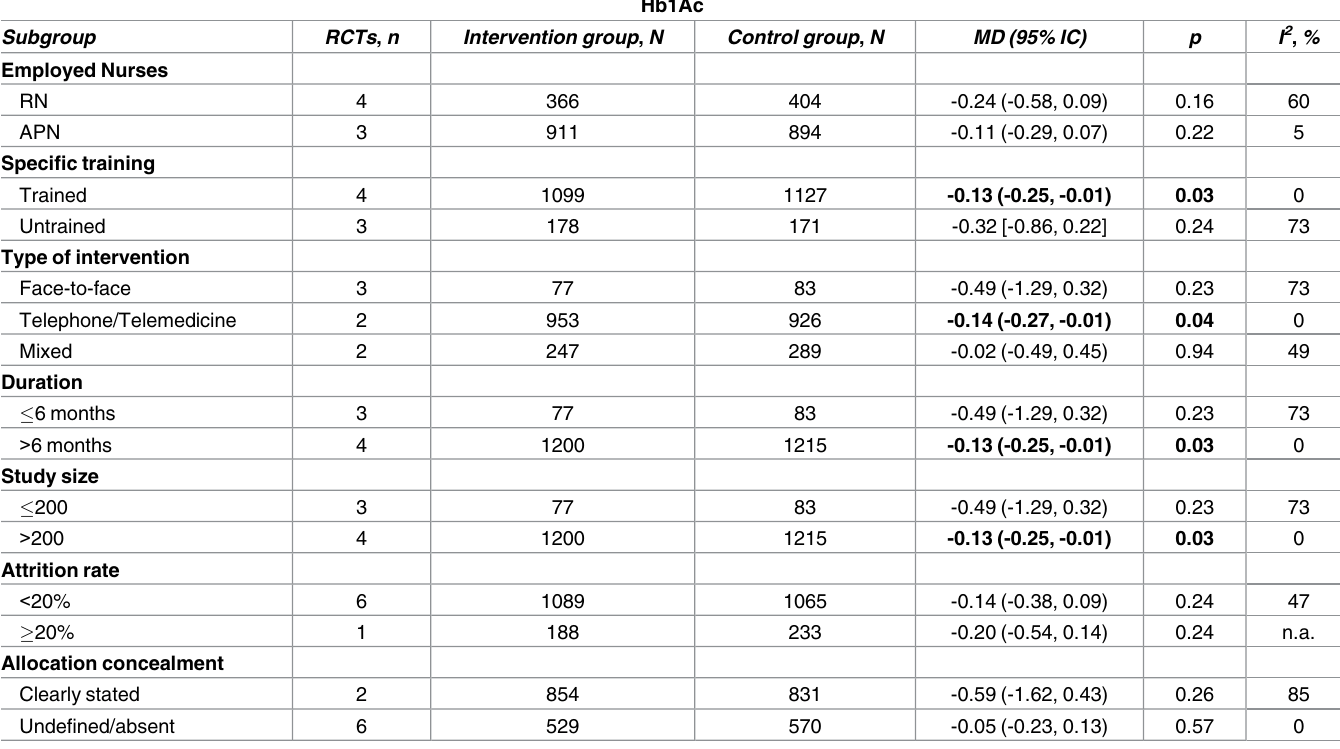
Table 5. Meta-analysis of the reduction of HbA1c levels in diabetic patients stratified by level and training of employed nurses; type and duration of the intervention; study size; attrition rate; allocation concealment.